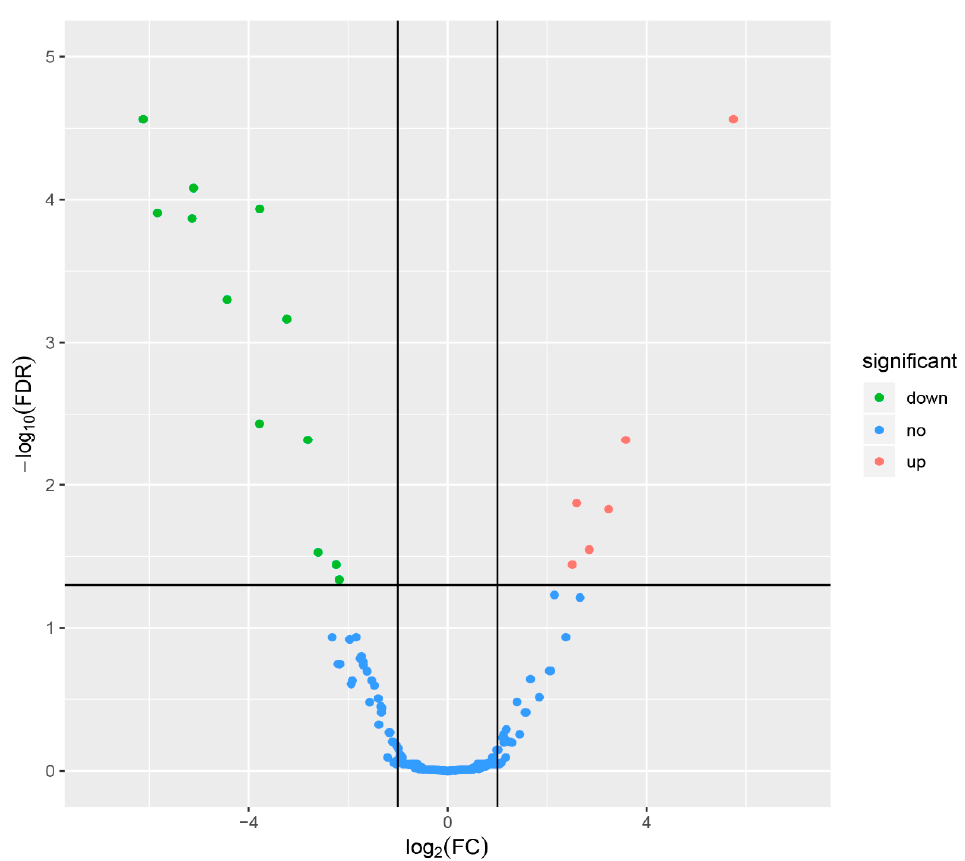
Figure 2. Scatter plot of the expression of the differentially expressed miRNAs between the high and low backfat groups. Red dots indicate up-regulated miRNAs in the high backfat group; green dots indicate down-regulated miRNAs in the low backfat group.